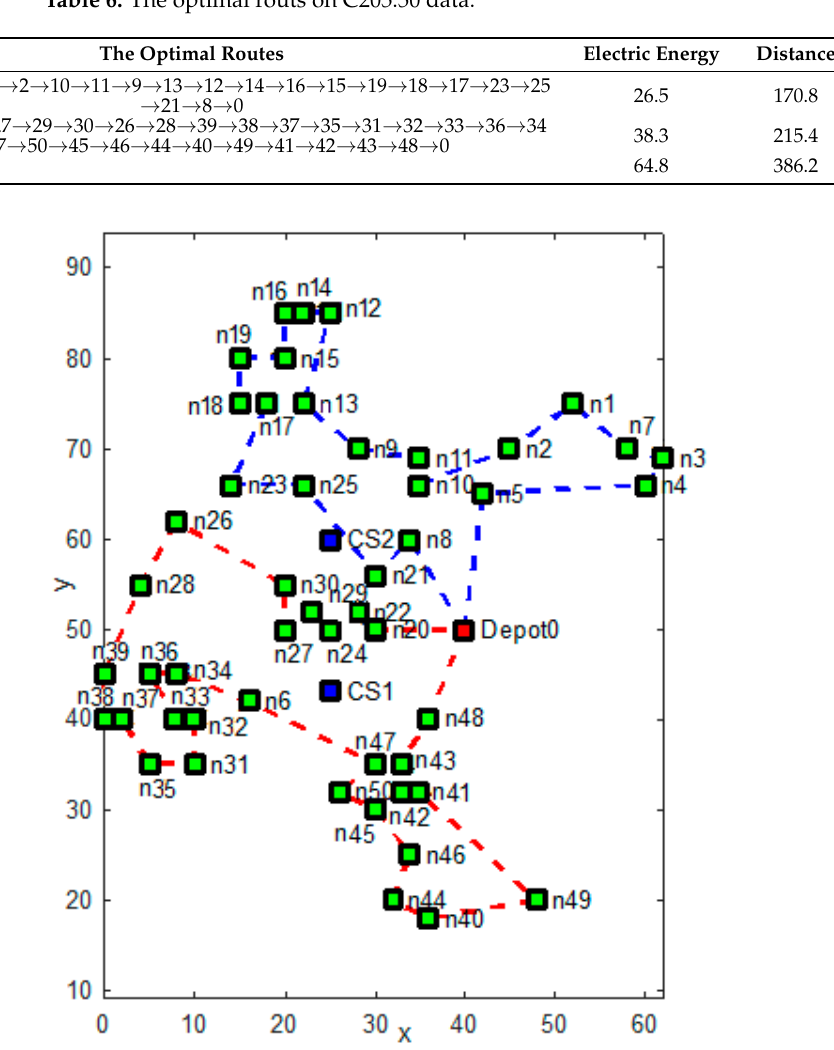
Figure 4. The optimal route diagram.